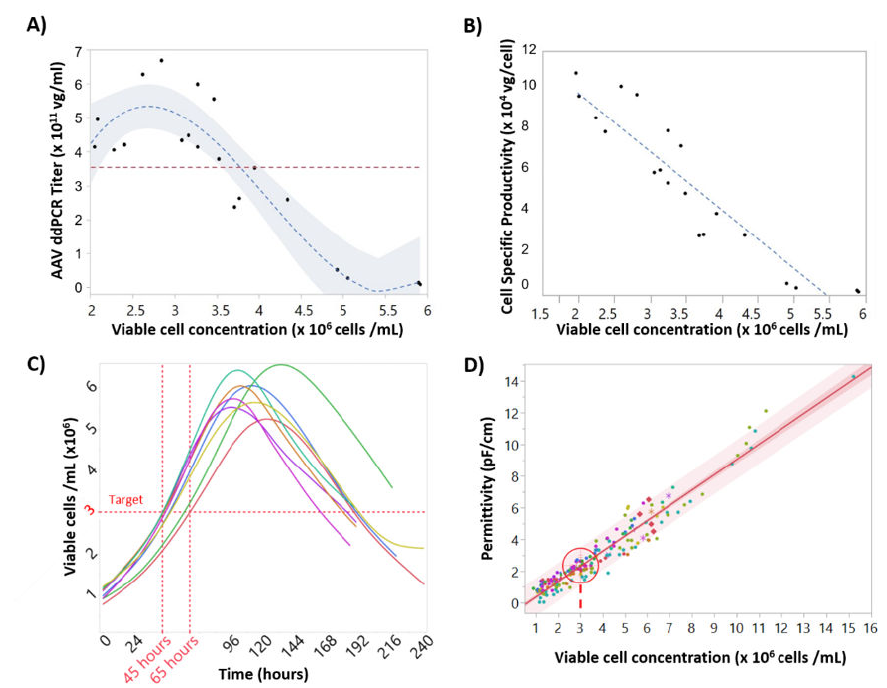
Figure 2. Impact of cell concentration on recombinant adeno-associated virus (rAAV) titers and correlations between cell concentration, cell specific productivity, and permittivity. ( A ) Model (dashed line) and 95% confidence intervals (shaded area) for the relationship between rAAV titer at day 6 and cell concentration at infection. ( B ) Linear correlation between cell concentration at infection and rAAV specific productivity. ( C ) Viable cell concentration time-course profiles for the “standard” batches, with coinfection with Rep / Cap and transgene-BIICs (baculovirus-infected insect cells). The time when the cells reached the target cell concentration at infection can vary up to 24 h. ( D ) Correlation between viable cell concentration measured by Vi-cell and permittivity values measured by the Incyte sensor. The target value of viable cell concentration of 3 × 10 6 cells / mL is represented by a target, corresponding to a permittivity value of 2.2 pF / cm (95% confidence interval = 2.18–2.34 pF / cm). R 2 adjs =